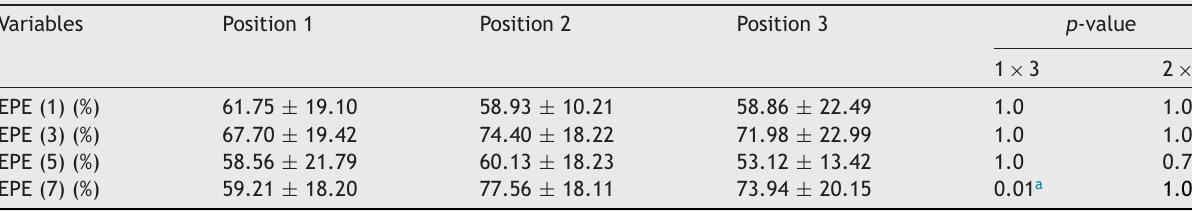
Table 3 Mean and standard deviation of the variable endpoint excursion (EPE) of the stability limit, as a percentage. Variables